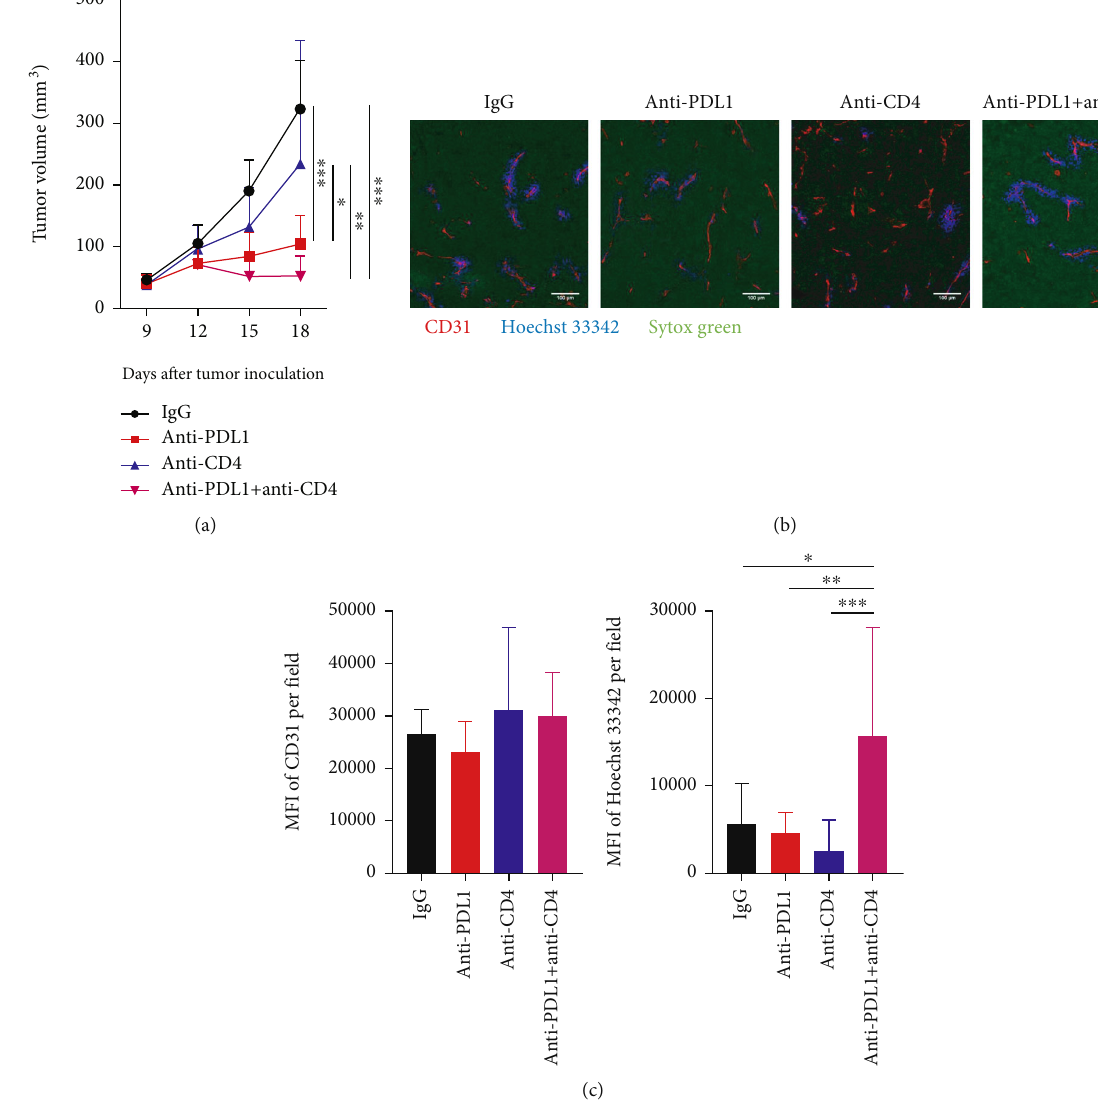
Figure 5: PD-L1 blockade with concurrent CD4 + T cell depletion induced vascular normalization and tumor regression in MCA38 colorectal tumors. C57BL/6J mice were inoculated with 2 × 10 5 MCA38 colon tumor cells. When MCA38 colon tumors reached 4-5mm in diameter (day 0), mice were randomly assigned to 4 groups and treated with anti-CD4 antibody on days -1, 1, and 8. On day 0, mice were treated with anti-PD- L1 (10mg/kg) or IgG (10mg/kg) antibody, every 3 days for 3 doses. On day 9 post anti-PD-L1 treatments, mice were intravenously injected with 200 μ g/mouse Hoechst 33342, and tumor tissues were harvested after 5 minutes of the injection. (a) Tumor volumes were shown in each time point for each group. (b) Representative fi gures showing Hoechst 33342-stained areas (blue) and immunohistochemical staining of CD31 (red). Scale bars: 100 μ m. (c) Total tumor blood vessel density and Hoechst 33342 perfused area were quanti fi ed. Signi fi cant di ff erences were determined by one-way ANOVA. Data were from one experiment representative of two independent experiments with similar results ( n = 6 − 8 mice per group). Data were shown as means ± SD . ∗ P < 0 : 05 , ∗∗ P < 0 : 01 , ∗∗∗ P < 0 : 001